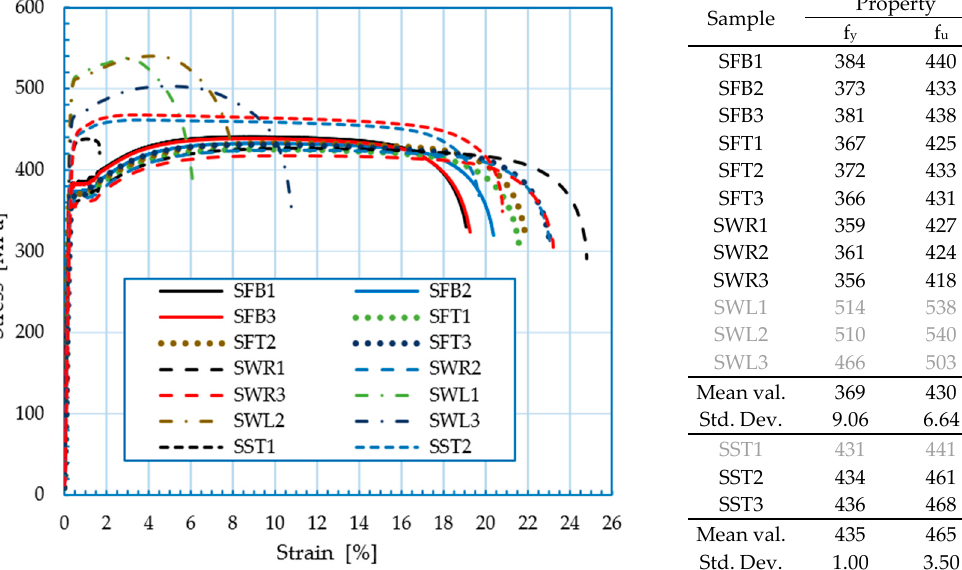
Figure 5. Performed testing procedures of butt welds between the beam and the column: ( a ) dye penetration test; ( b ) sample extraction; ( c ) bending test; ( d ) macrograph analysis; ( e ) static tension test.